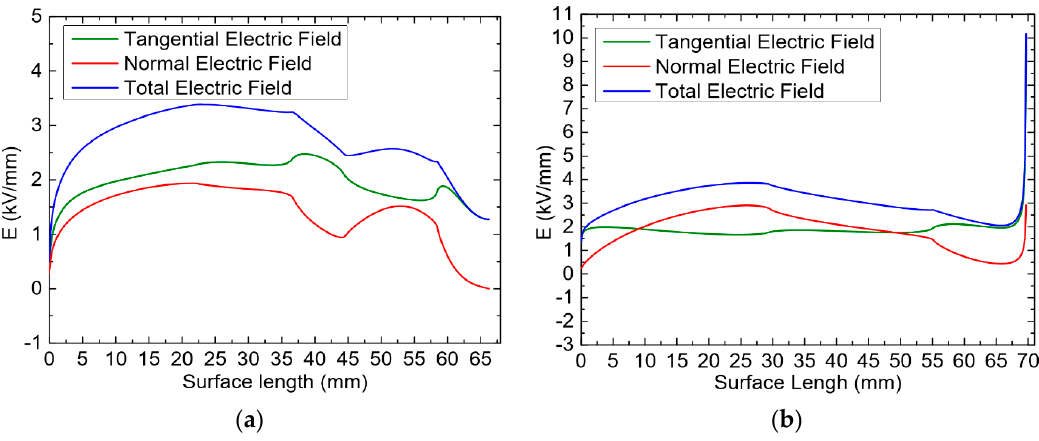
Figure 7. Computed tangential, normal, and total electric field distributions on the upper surface of the optimized spacer ( a ) in comparison with that of the initial configuration ( b ).